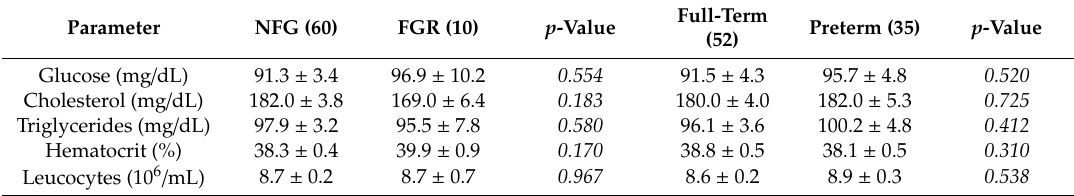
Table 2. Maternal blood parameters, according to the development of FGR or preterm labor.